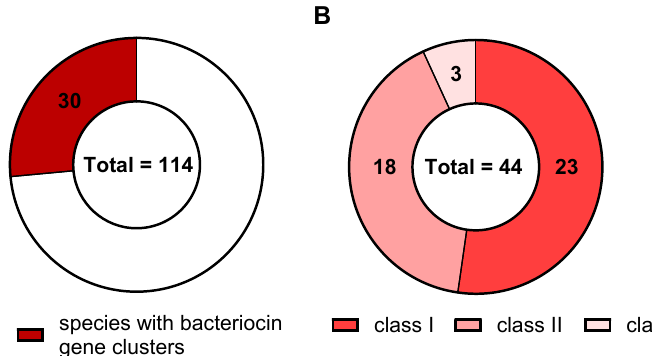
Figure 4. Analysis of bacteriocin gene clusters (BGC) in the genomes of 114 Corynebacterium spp. ( A ) Total number of Corynebacterium spp. with identified BGCs amongst all species analyzed. ( B ) Total number of BGCs in analyzed Corynebacterium spp. genomes grouped according to the three classes of bacteriocins. Analysis was performed using BAGEL4 and BLASTP.